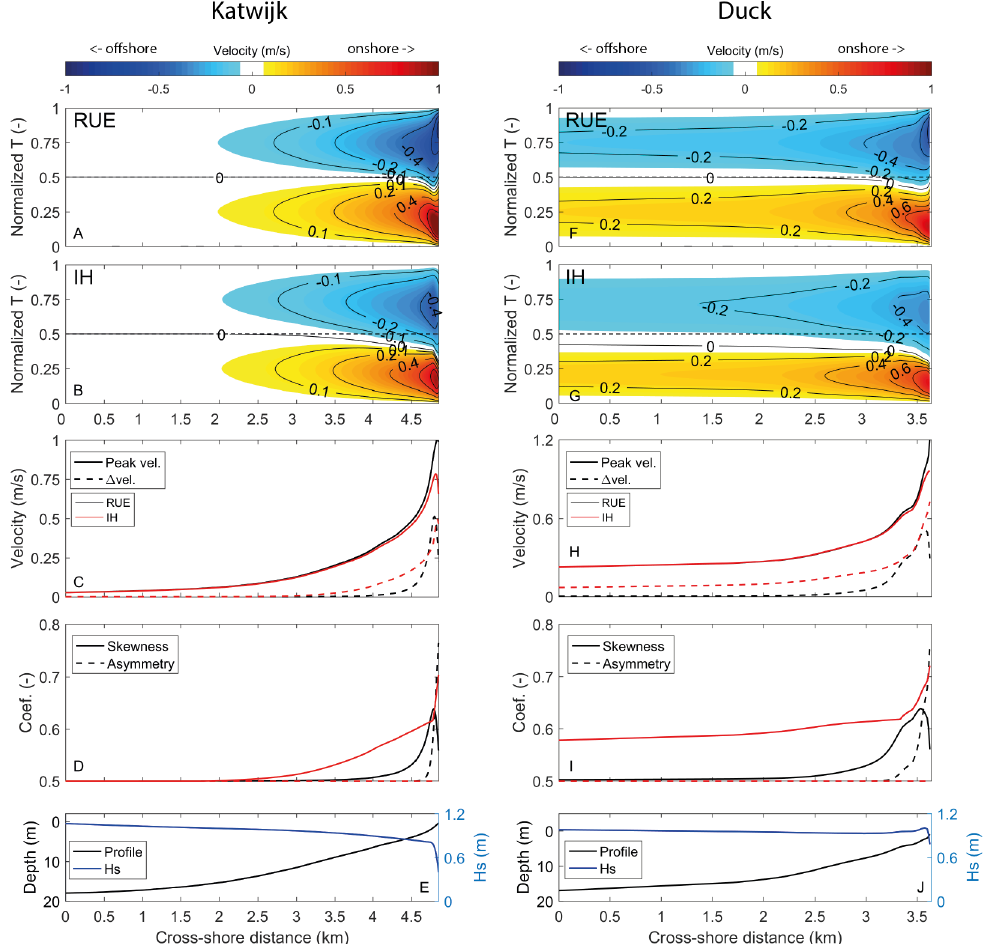
Figure 3. Hydrodynamic comparison between RUE and IH behaviour for the average wave condition (Wave 7) along the beach profiles of Katwijk (( A – E ) left) and Duck (( F – J ) right). Orbital velocities (positive onshore and negative offshore) within the wave period T for RUE ( A , F ) and IH ( B , G ). ( C , H ) Peak orbital velocity and the difference between onshore and offshore velocity amplitude ∆ vel = | u on | − | u of f | , color-coded for RUE and IH. ( D , I ) Skewness and Asymmetry coefficients. ( E , J ) Beach profile and significant wave